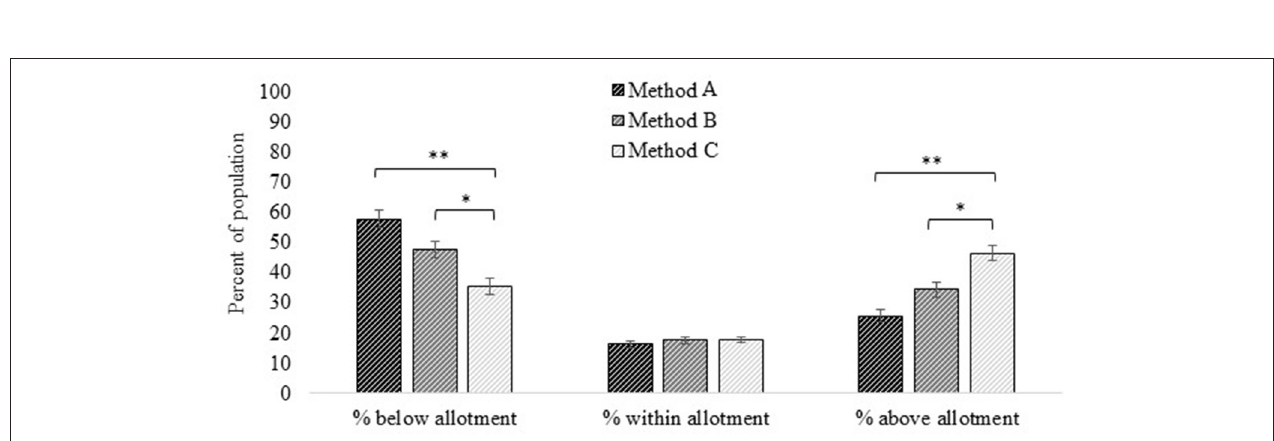
FIGURE 5 | Red meat intakes compared to allotment ranges in the US 2020-25 Dietary Guidelines for Americans recommended eating patterns, by age and sex, estimated via different methods. Method 1: Unprocessed red meat, includes beef, veal, pork, lamb, and game meat; excludes organ meat and processed meat. Method 2 (reference): Total red meat, includes unprocessed red meat and processed red meat. Method 3: Red and processed meat, includes unprocessed red meat, processed red meat, and processed poultry. Method 4: Red and processed meat, additionally including chicken patties, nuggets, and tenders. See Figure 1 for further descriptions of each method. Results are shown as mean estimated via the NCI Method for usual dietary intakes. Data source: US Centers for Disease Control and Prevention/National Center for Health Statistics, NHANES 2015-2018, day 1 and 2 dietary recall data.